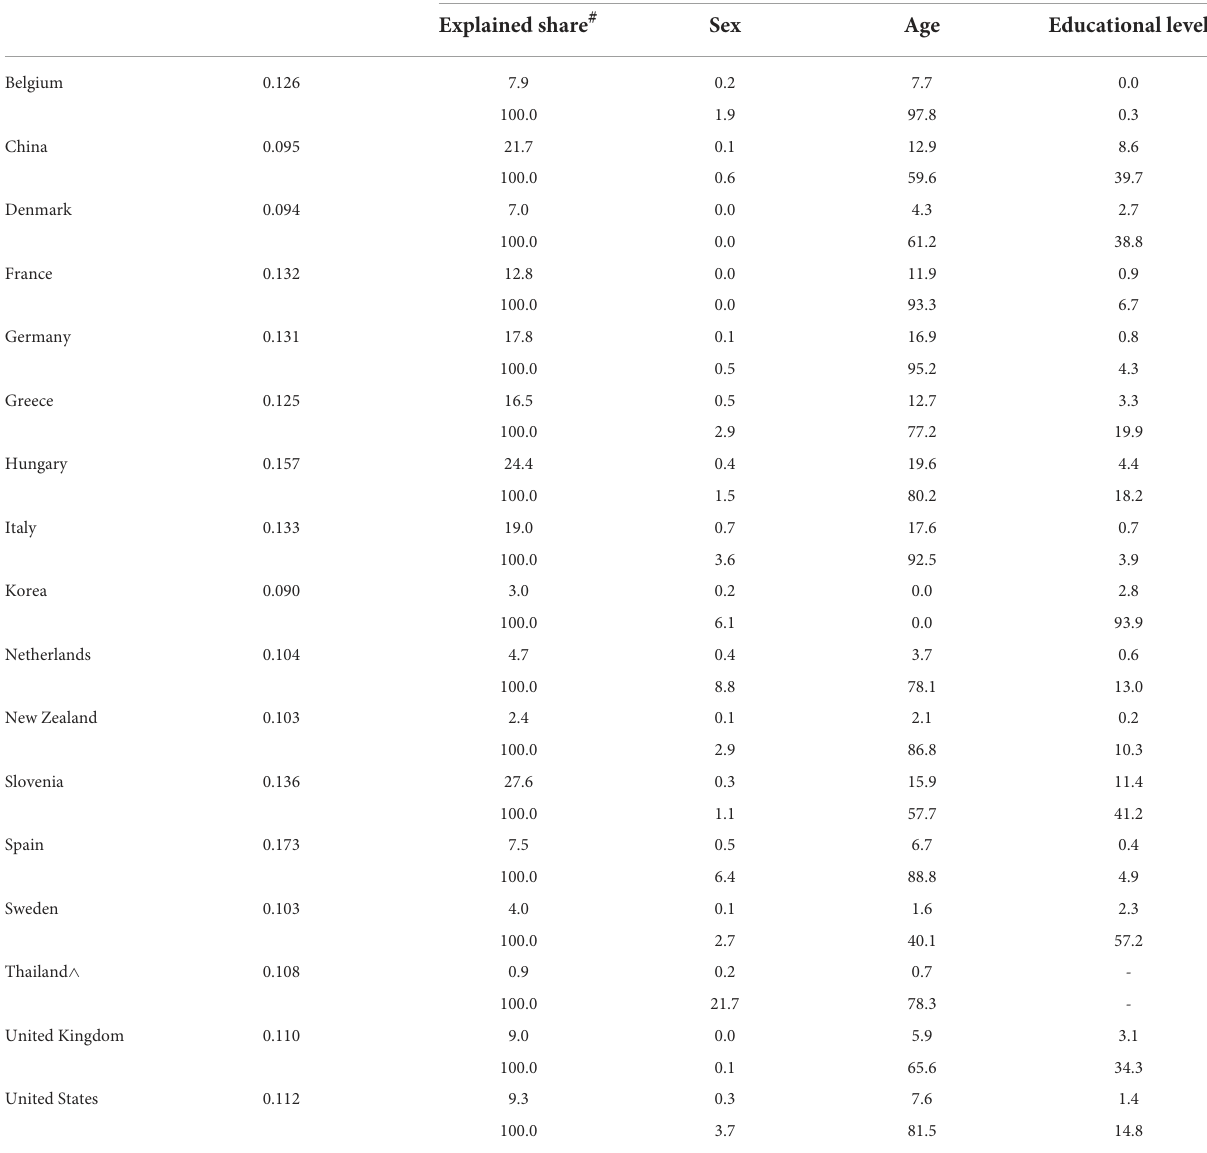
TABLE 5 Health concentration index based on overall self-assessed health measured on the EQ VAS as explained by socio-demographic indicators. Country Concentration index* Socio-demographic indicator (absolut % and relative %) Explained share # Sex Age Educational